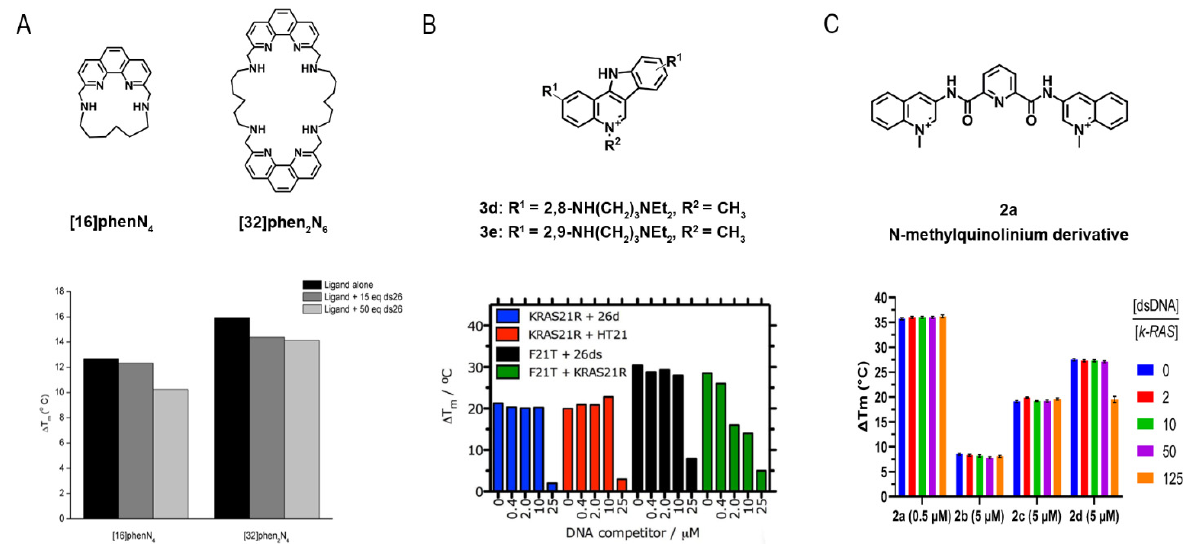
Figure 21. ( A ) Chemical structures of (16)phenN 4 and (32)phen 2 N 4 and FRET-melting stabilization by (16)phenN 4 and (32)phen 2 N 4 (1 μ M) of the labelled F21T sequence (0.2 μ M) in buffer 10 mM KCl + 90 mM LiCl and in the presence of